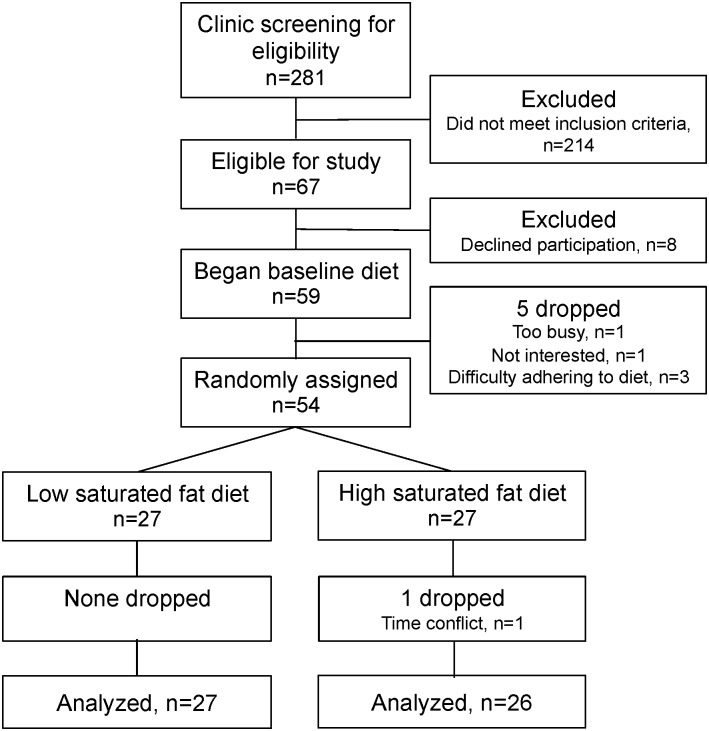
CONSORT flow diagram.